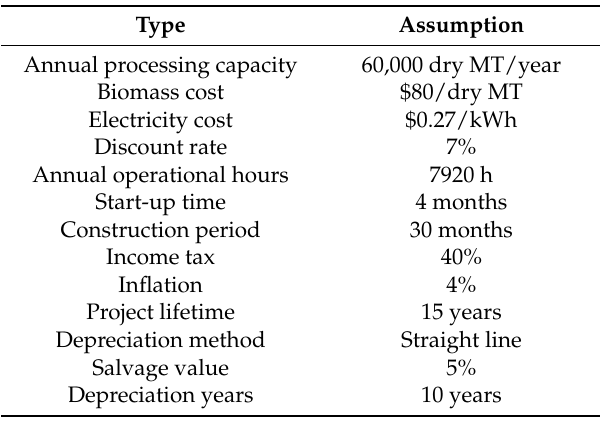
Table 2. List of assumptions used in this